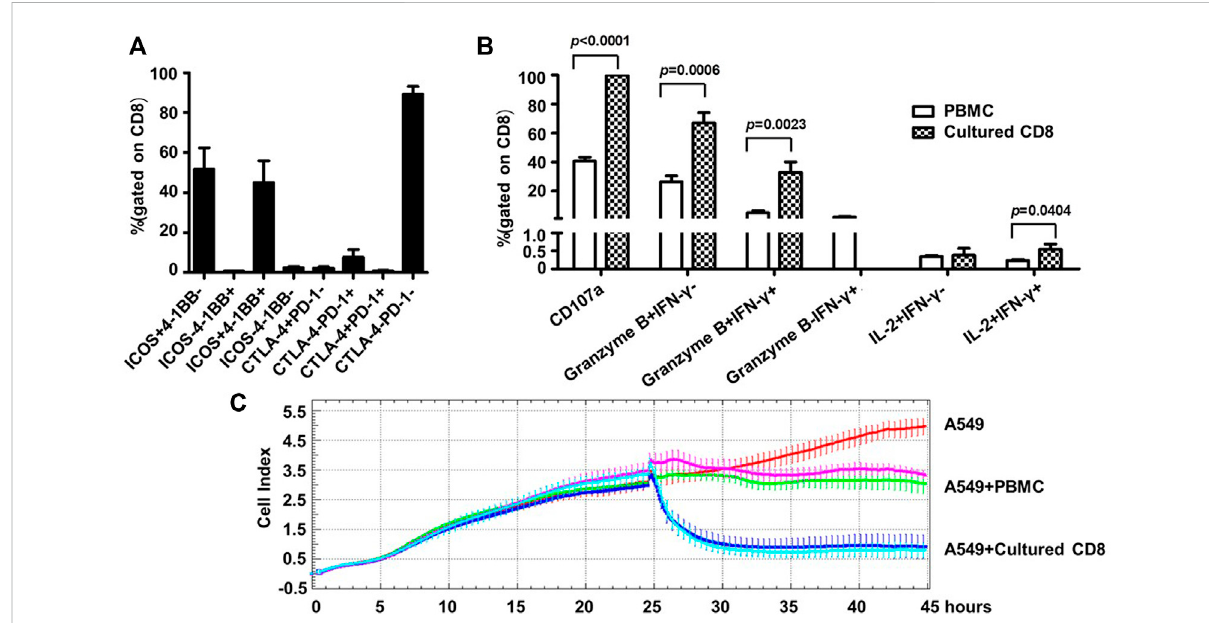
FIGURE 4 Human blood-derived PD1+ CD8 + T cells expanded by the new TLR agonists-aided method demonstrated strong effector and anti-tumor capacities. (A) Expression of co-stimulatory molecules (ICOS and 4-BB) and co-inhibitory molecules (CTLA-4 and PD-1) on the expanded PD1+ CD8 + Tcells, assessed by fl ow cytometry. Shownisaggregateddata of fi vesamples. (B) Assessmentsoffunctional capacityof expandedPD1+ CD8 + T cells as effector cells. The expanded PD1+ CD8 + T cells were stimulated with anti-CD3/anti-CD28 beads in the presence of anti-CD107a, followedbytreatmentwithsecretioninhibitorbrefeldinAfor5 h,andsubsequentlyharvestedforintracellularstainingwithmarkersgranzymeB,IFN- γ and IL-2 before analyzing by fl ow cytometry (n = 5). (C) Tumor cell killing activity of expanded PD1+ CD8 + T cells. A549 cells were seeded at 1×10 4 cells per well and incubated for 24 h before adding 1×10 5 PBMC or the expanded CD8 + T cells. The co-culture was monitored for A549 cell index by RTCA system for 45 h. Shown are results of two representative